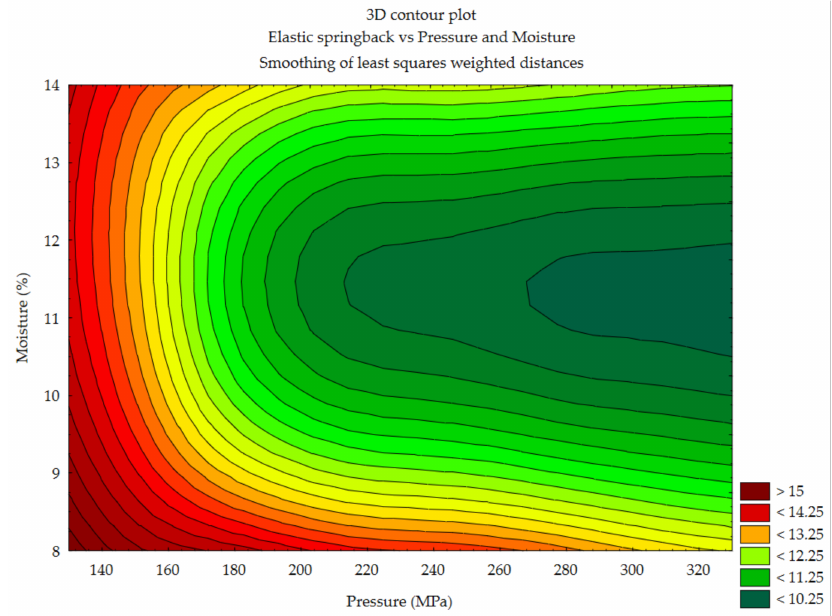
Figure 7. Elastic springback vs. pressure and